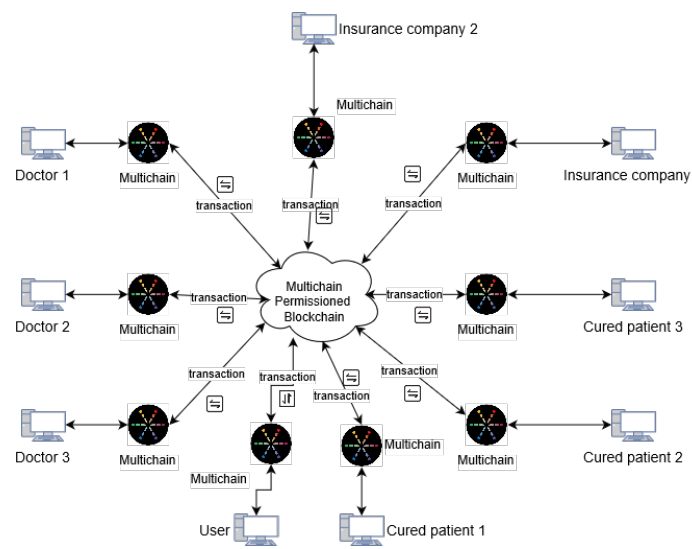
Figure 13. PoF communication (transaction) environment tested in the Multichain 2.0 environment.